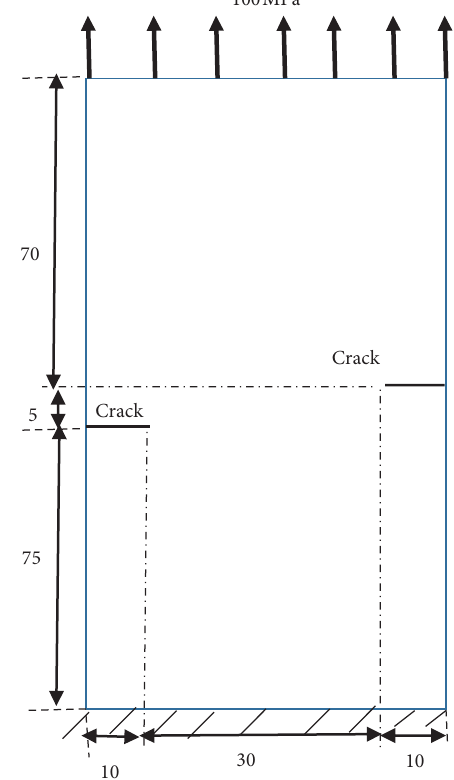
Figure 12: Thin plate containing two eccentric edge